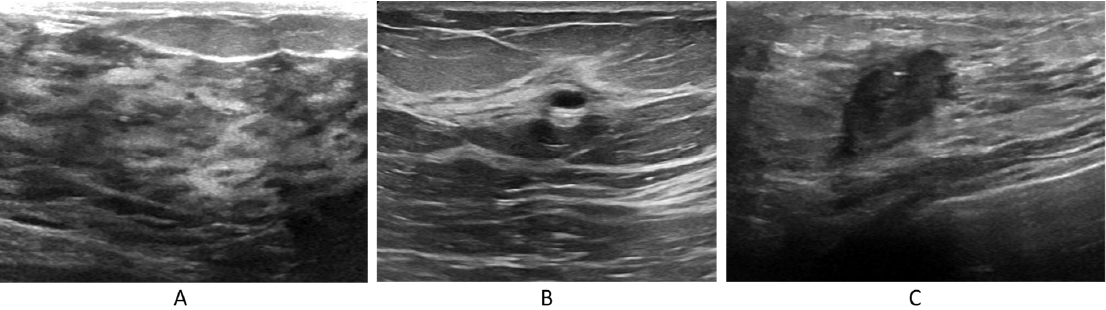
Figure 4. Samples from the breast cancer dataset: ( A ) normal; ( B ) benign; and ( C ) malignant.